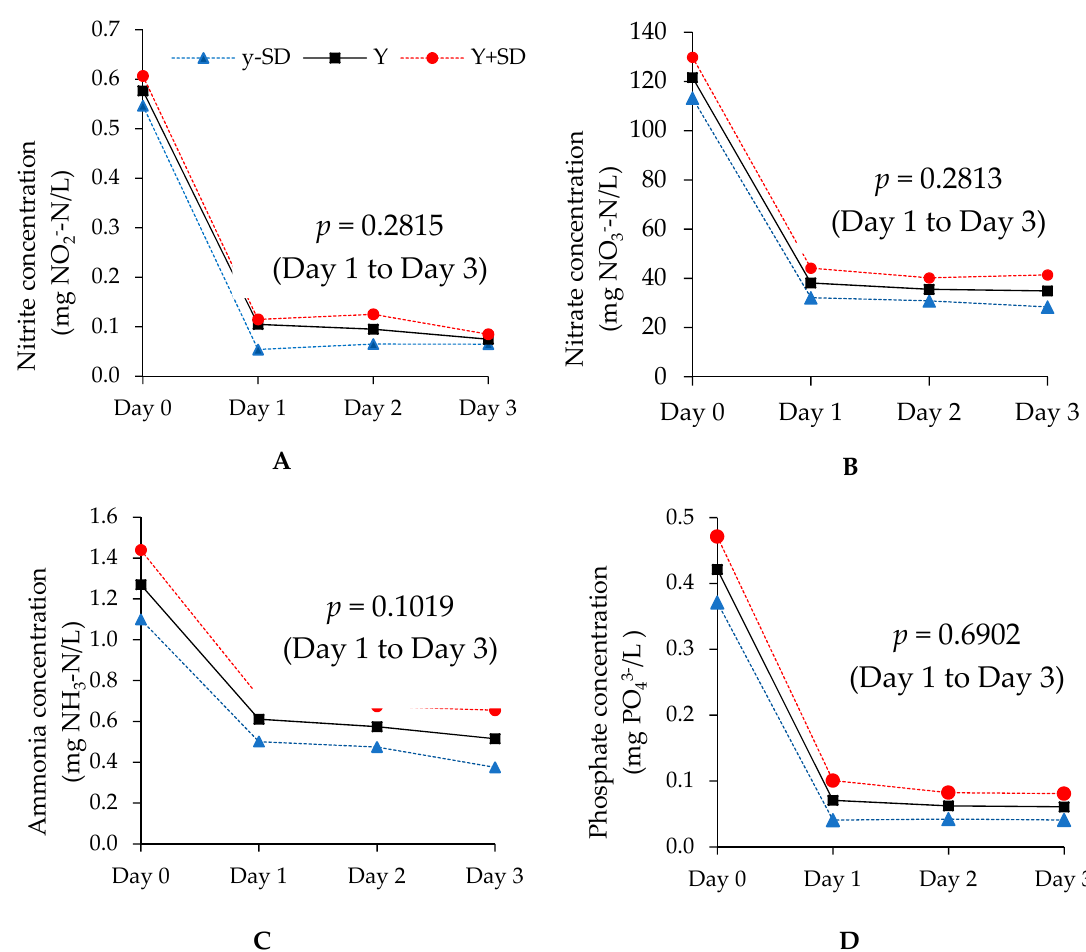
Figure 2. Mean concentrations of ( A ) nitrite nitrogen (NO 2 − -N); ( B ) nitrate nitrogen (NO 3 − -N); ( C ) ammonia nitrogen (NH 3 -N); and ( D ) phosphate (PO 43 − ) on Days 0, 1, 2, and 3 with the standard deviation range (n = 15). The p values are for ANOVA for Day 1 to Day 3.